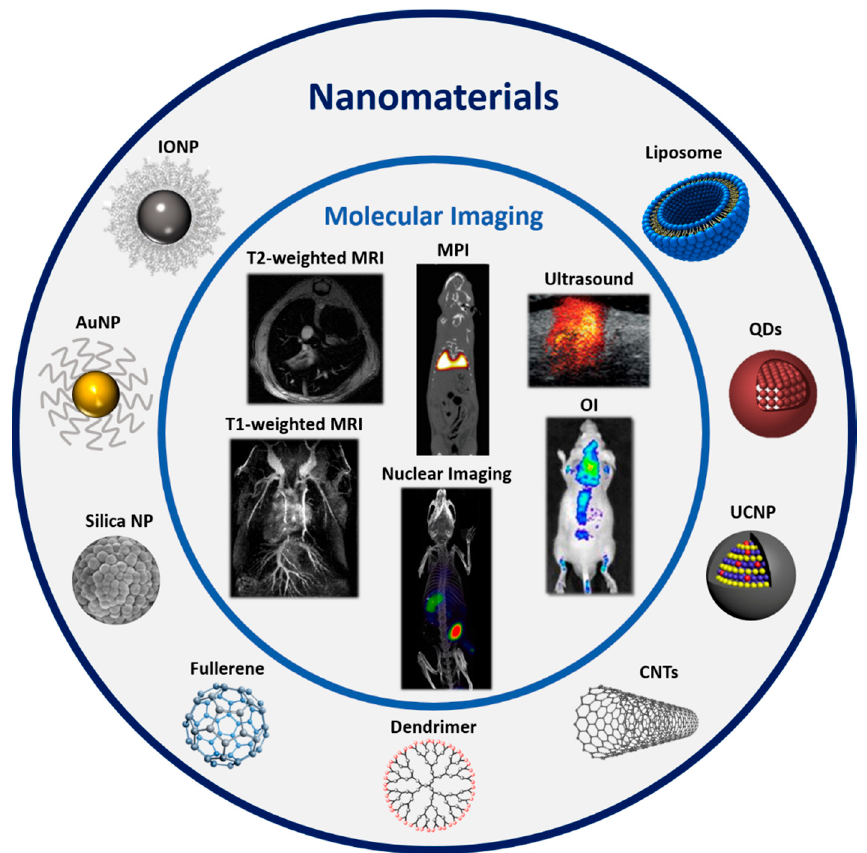
Figure 3. Different types of nanomaterials and the molecular imaging modalities to which they are applied. Ultrasound image adapted from Evertsson et al. [69], nuclear imaging image adapted from Lee et al. [79], Optical Imaging (OI) image adapted from Zheng, M. et al. [80], Magnetic Particle Imaging(MPI) image adapted from Zheng, B. et al. [81].